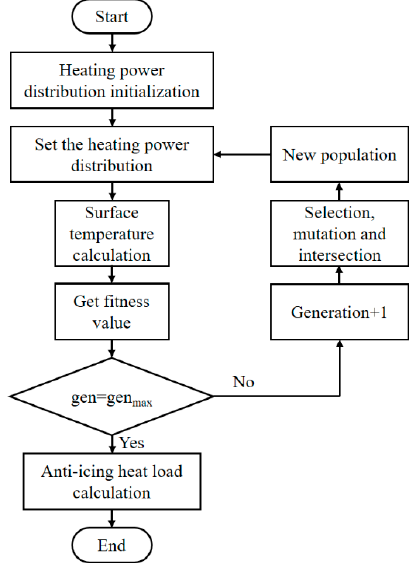
Figure 3. Flow chart of the optimization method by the genetic algorithm.